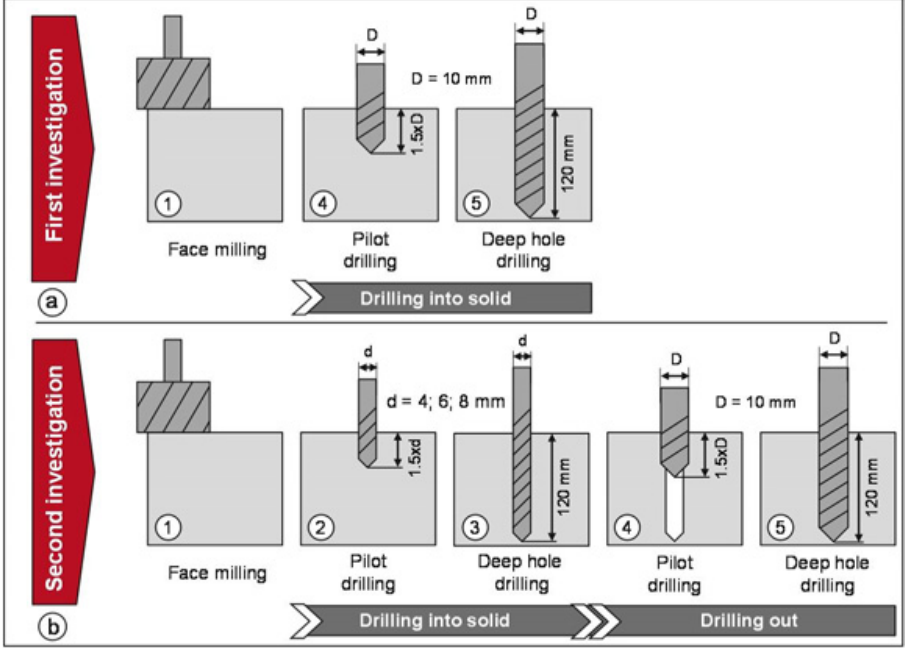
Figure 3. Process chain for the second step of the experimental investigation .